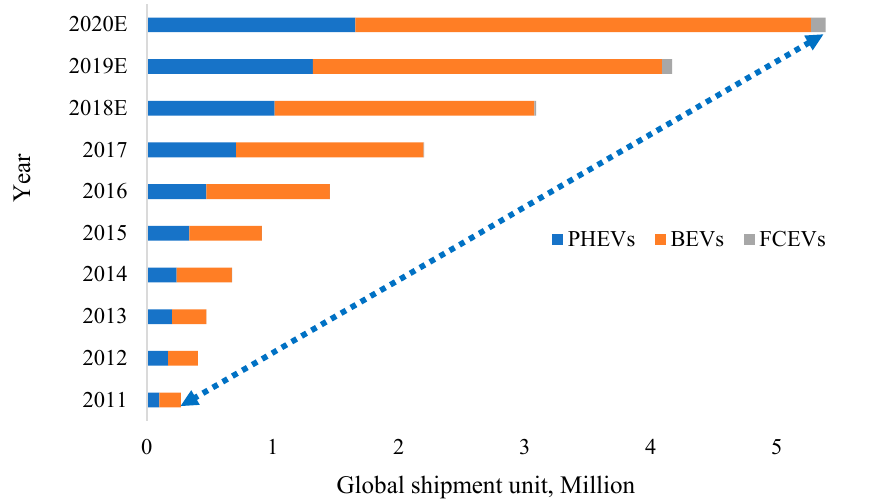
Figure 2 . Estimated global shipments of EVs and PHEVs (2017 International Energy Agency (IEA) report [19]) .